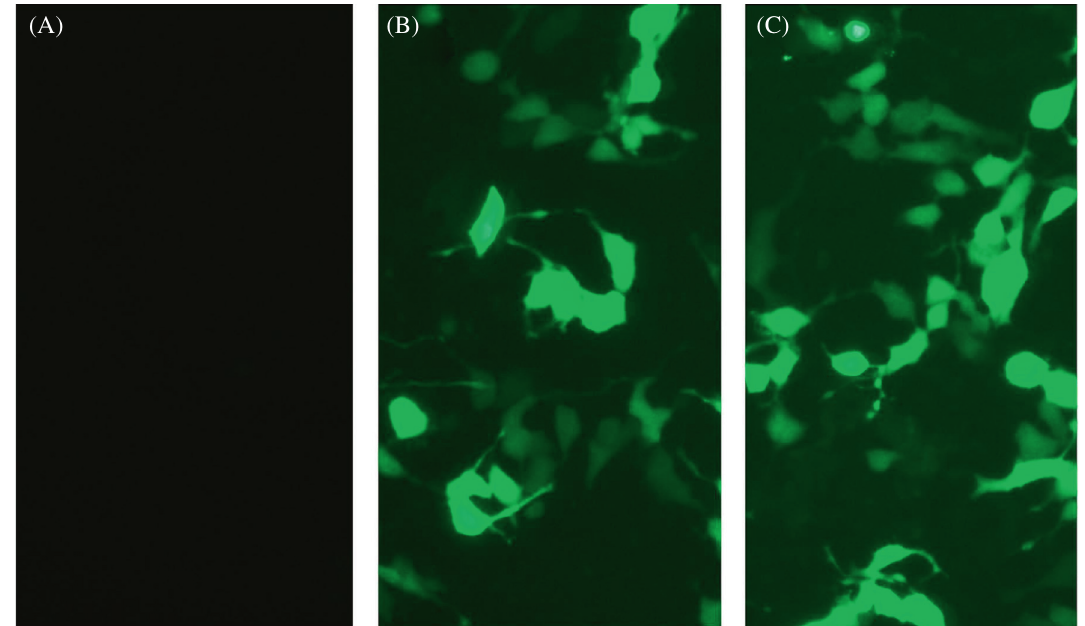
Figure 2. Direct immunofluorescence detection of the fusion protein in transfected HEK 293-T cells. (A) Untransfected cells were detected under blue light; (B) cells transfected with pEGFP-C1 were detected under blue light; (C) cells transfected with pROP19 were detected under blue light. Excitation wavelengths = 490 nm; Emission wavelengths = 520 nm.